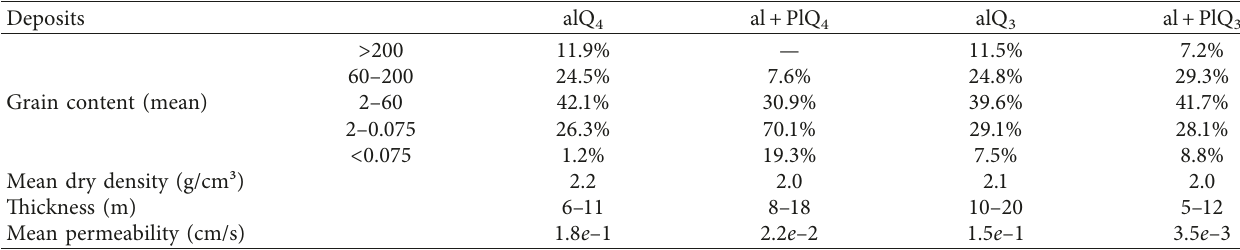
Table 3: Physical properties of the overburden layers in the Maoergai dam.